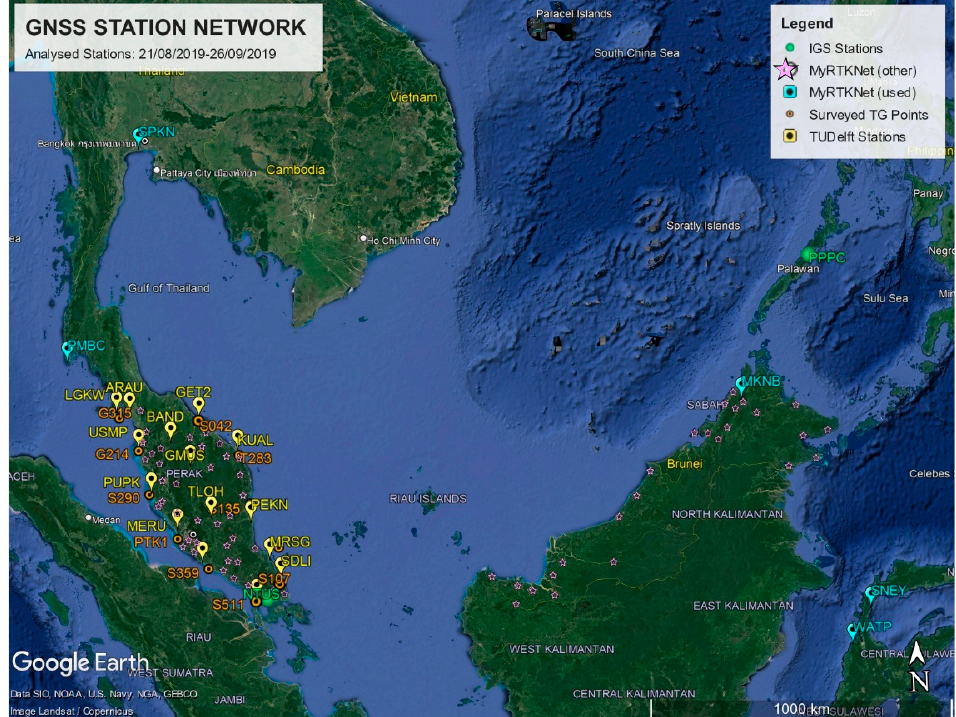
Figure 3. Overview of the GNSS stations that were used in the data analysis. In total, GPS data from 35 locations were used, including 11 TG points (in red), 15 MyRTKNet stations in Peninsular Malaysia (yellow place markers), 5 TUDelft stations (orange place markers) in Thailand, Eastern-Malaysia, and Sulawesi Indonesia, and 4 IGS stations (green dots) in Thailand, Singapore, and the Philippines. The other MyRTKNet station locations in Malaysia are also shown (yellow star markers). Source of Image: Google Earth Pro.